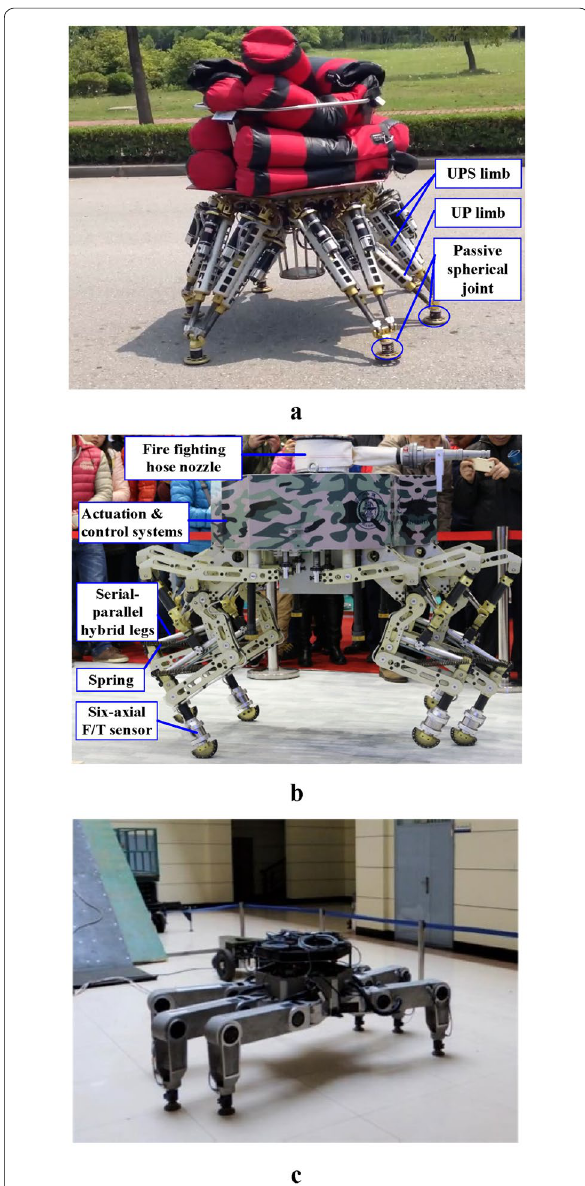
Figure 8 High payload hexapod robots: a Octopus; b Hexbot-IV; c HIT hexapod robot